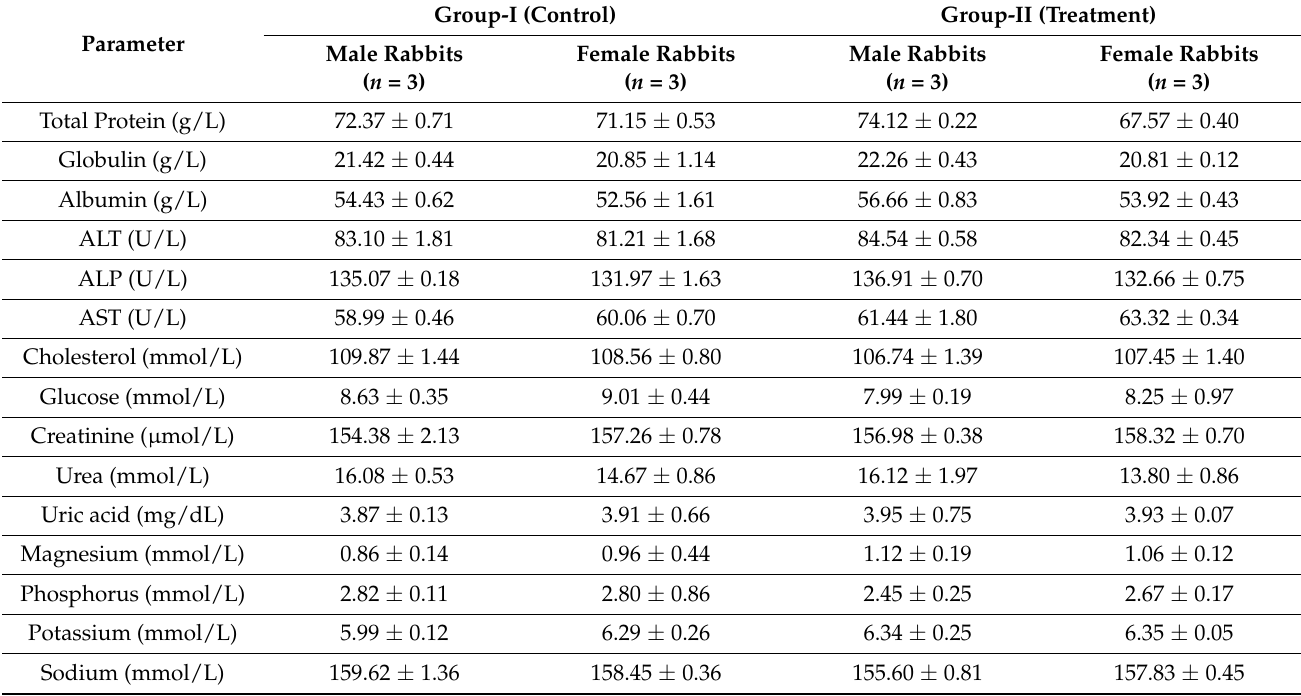
Table 3. Serum chemistry profile (hydrogel dispersion) of the control and treatment groups ( n = 6 rabbits: 3 male rabbits and 3 female rabbits) for